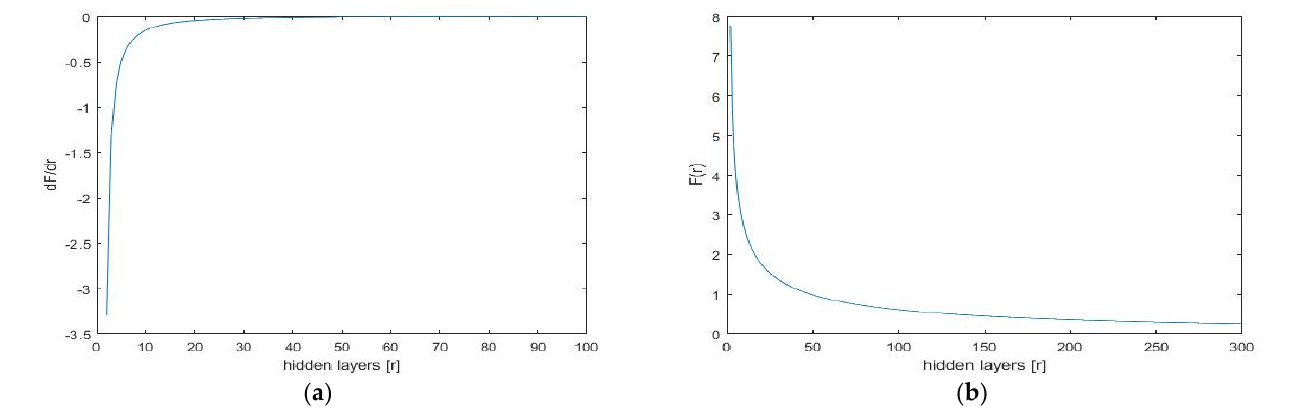
Figure 5. ( a ) The derivative function ∂ F /∂ r trends to zero from below as the number of layers increases. ( b ) The function F ( r ) is decreasing with respect to the number of layers.